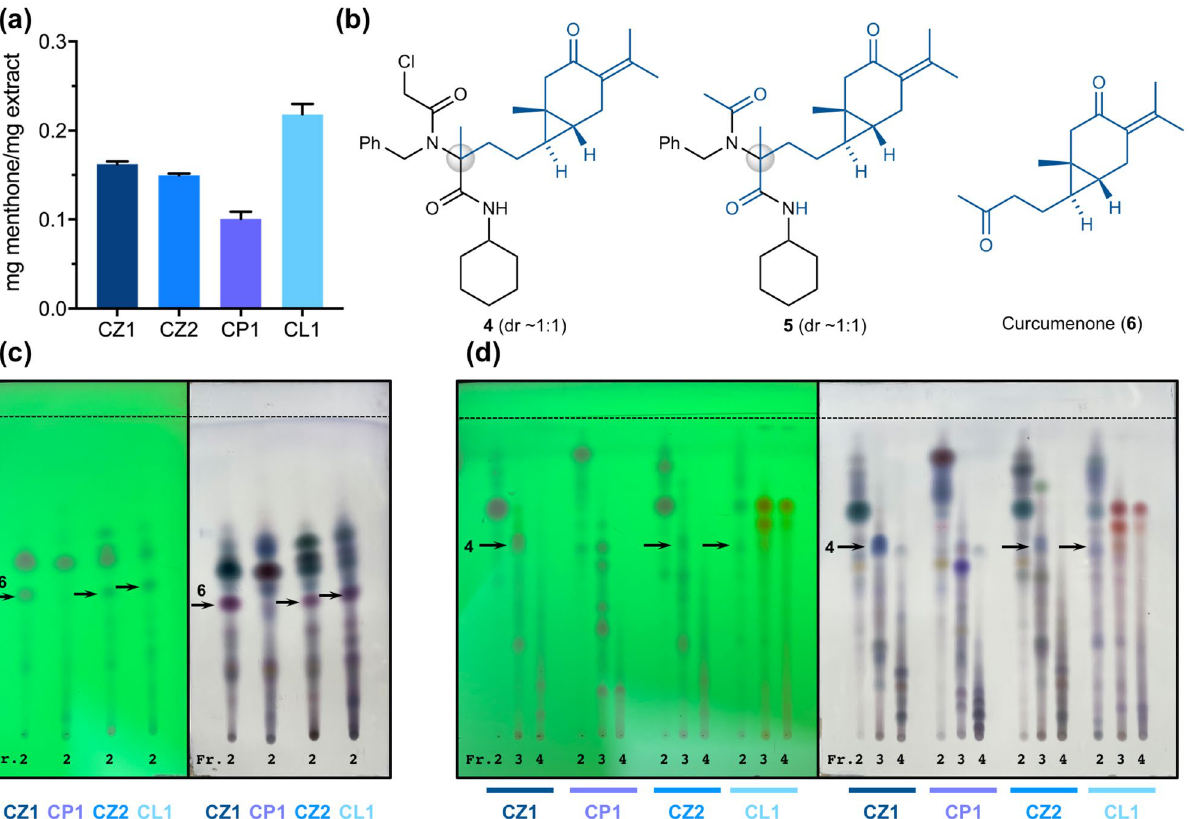
Figure 3. ( a ) Carbonyl content of the extracts. ( b ) Structures of Ugi adducts 4 and 5 , and curcumenone ( 6 ). ( c ) TLC of fraction No. 2 of the untreated extracts. The TLC was developed with hexane/ethyl acetate (4:1) and then visualized by UV light at 254 nm (i) or by staining with an acidic solution of p -anisaldehyde (ii). ( d ) TLC of fractions No. 2–4 of the engineered mixtures. The TLC was developed with 1,2-dichloroethane/ethyl acetate (19:6) and then visualized by UV light at 254 nm (i) or by staining with an acidic solution of p -anisaldehyde (ii). The dashed lines in ( c ) and ( d ) indicate the solvent front.